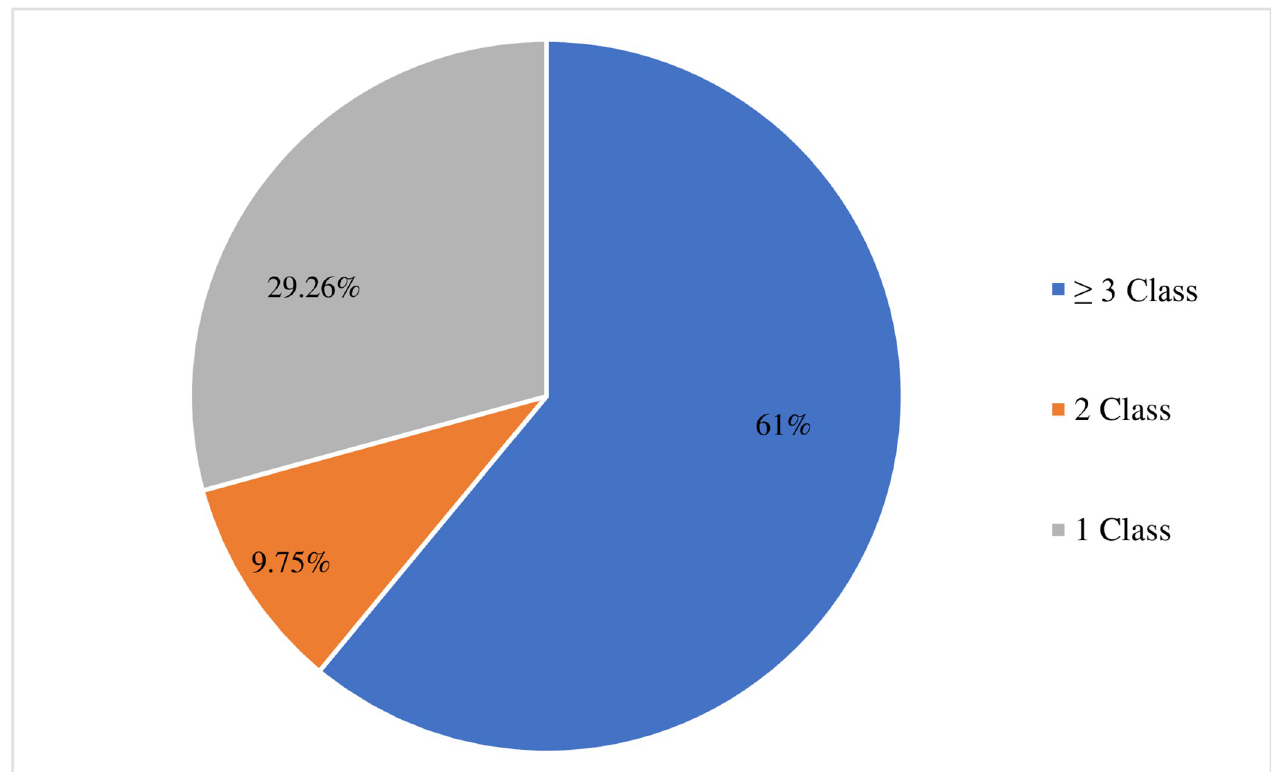
Fig 2. Percentages of S . aureus isolates resistant to the different antimicrobial classes.